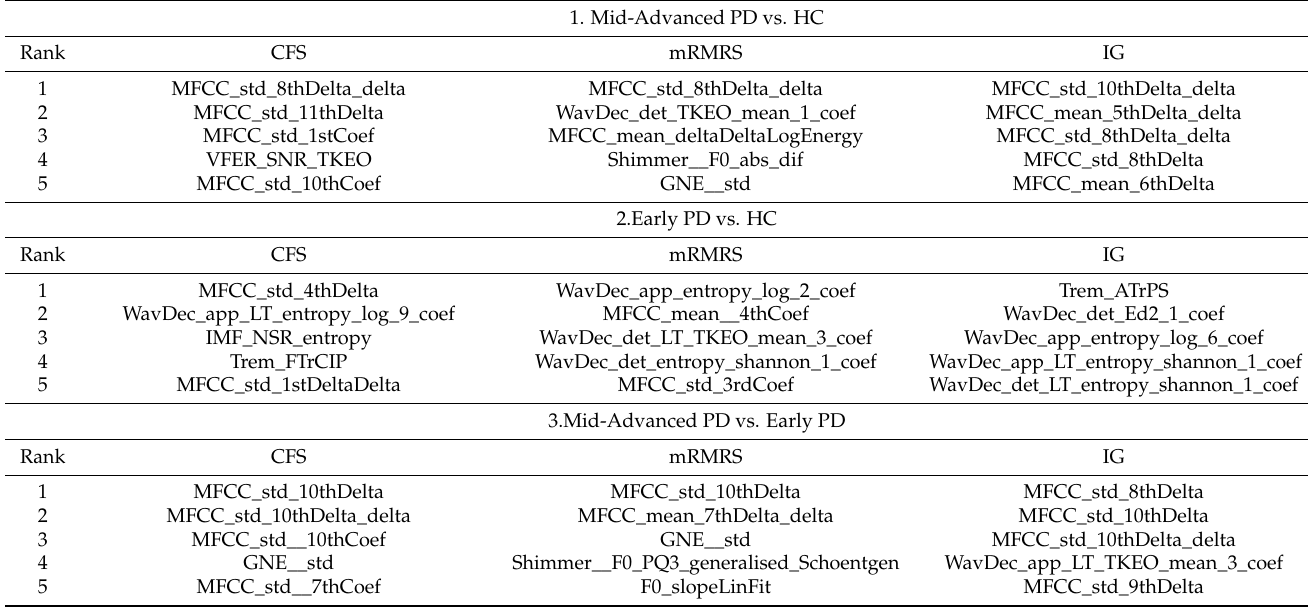
Table 8. Best five features according to the three different feature selection algorithms employed. Results are reported for each binary and multiclass analysis